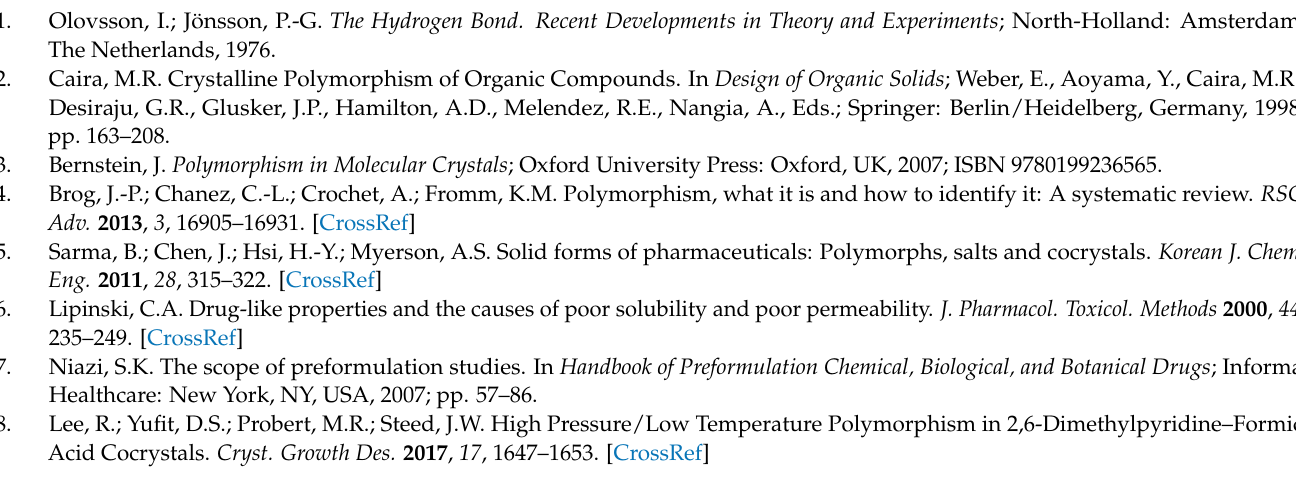
Figure S7: Hirshfeld surfaces and fingerprint plots showing all interactions (a), only C ··· H/H ··· C interactions (b), only O ··· H/H ··· O interactions (c), only N ··· H/H ··· N interactions (d), only H ··· H interactions (e), only C ··· C interactions (f) and voids in the unit cell (g) for the sample form III; Figure S8: TGA curve heating the sample form II from 30 to 500 ◦ C with a step of 10 ◦ C/min; Figure S9: DSC heating and cooling curves for the sample form II. The curve in green represents the 1st heating (0.50 ◦ C/min), in blue the 1st cooling (0.75 ◦ C/min), in purple the 2nd heating and in brown the 2nd cooling; Figure S10: Diffractograms for variable temperature X-ray powder diffraction experiments at five different temperature points (T range between 25 and 60 ◦ C); Figure S11: Diffractograms at room temperature after the crystallization from the melt; Figure S12: Diffractograms for variable temperature X-ray powder diffraction experiments at 24 different temperature points ( T range between − 170 and 55 ◦